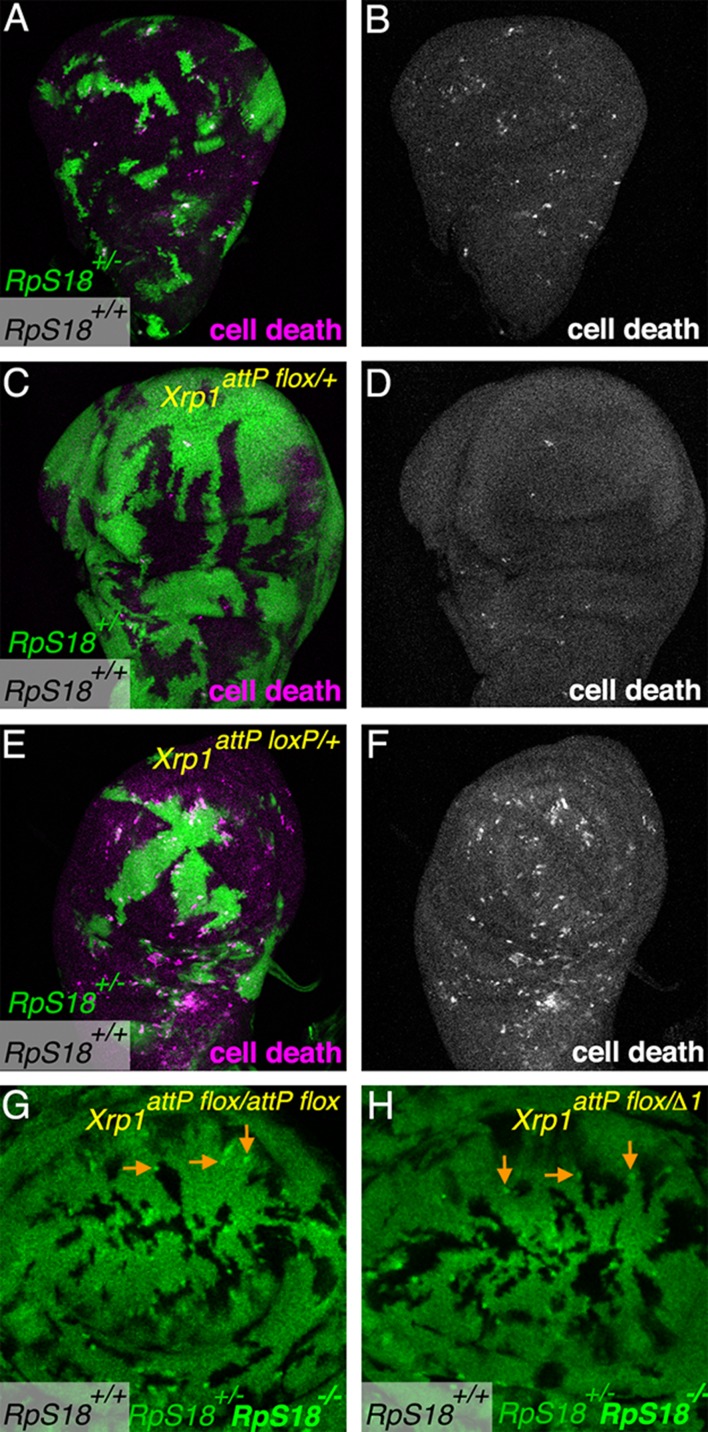
Xrp1attP flox is a loss-of-function allele.(A) As clones of RpS18+/+ cells (unlabelled) expand to occupy most of a RpS18+/- wing imaginal disc (green, GFP labeling), apoptosis is elevated especially at the boundaries between the cells (magenta labeling for activated effector caspase DCP1). (B) anti-DCP1 labeling from panel A). (C). RpS18+/+ clones occupy less of an RpS18+/-Xrp1 attP flox/+ wing imaginal disc, and cell death is rarely detected, as in other Xrp1 mutant genotypes (eg see Figure 1D). (D) anti-DCP1 labeling from panel C). (E). In the Xrp1attP loxP/+ background, RpS18+/+ cells expand to occupy most of a RpS18+/- wing imaginal disc, inducing apoptosis at the boundaries, as typical of Xrp1+/+ genotypes. (F) Anti-DCP1 labeling form panel E). (G). Small RpS18-/- clones persist in the Xrp1attP flox/attp flox background (eg arrows), as in other Xrp1-/- backgrounds (eg see Figure 1E). (H) Small RpS18-/- clones persist in the Xrp1attP flox/Δ1background (eg arrows), as in other Xrp1-/- backgrounds (eg see Figure 1E). Xrp1Δ1 is a deletion encompassing the Xrp1 locus (Lee et al., 2018).